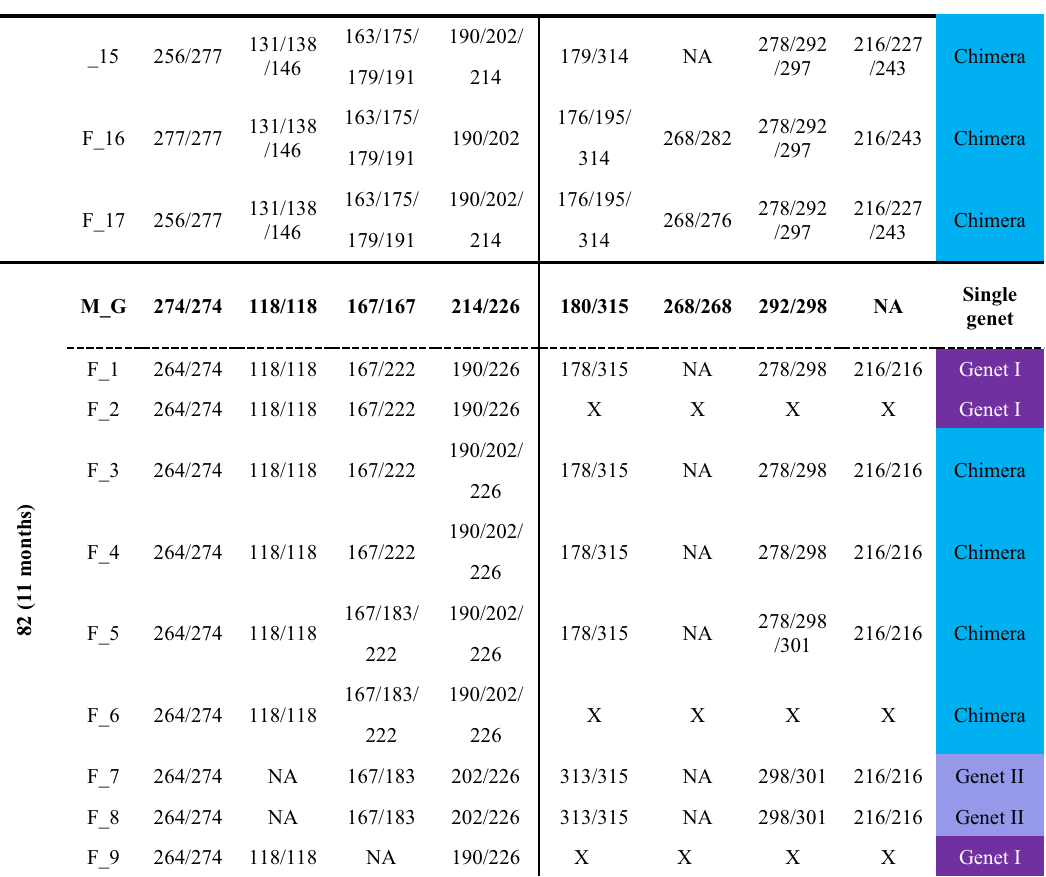
Table 2. Microsatellite (S_n) allele sizes (bp) in Stylophora pistillata maternal colonies (M) and fragments (F) of the chimeric spat (ID). The classification of each fragment (F_n) as chimera, cryptic chimerism (CR-Chim), Genet I or Genet II, is provided in the fragment type (FType) column. The location of each fragment within a given chimera is presented in Fig. 1a–d5. NA data not available due to no visible peaks or weak peaks (< 100 fluorescence units) in the electropherogram; X fragments with degraded